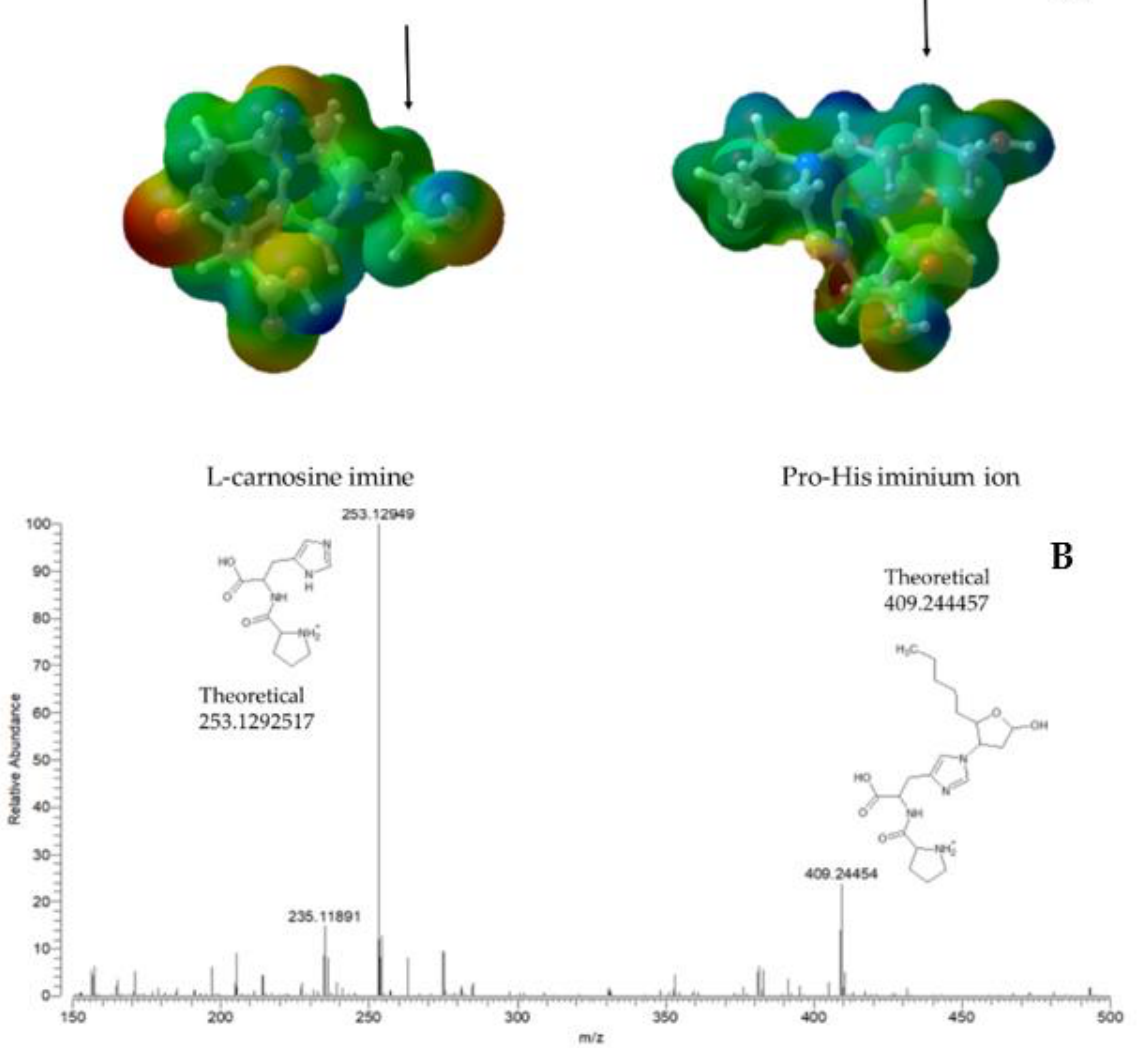
Figure 3. Comparison between the MEP surfaces (blue and red areas encode for electropositive and electronegative regions) for the imine intermediate of L -carnosine with HNE (here and in the following DFT simulations the pentyl chain was removed to speed up the calculations) and the corresponding iminium ion of Pro-His (( A ) the black arrow points out the reactive β carbon atom) and mass spectrum (positive-ion mode) of the reaction mixture (Pro-His + HNE) after 3 h incubation ( B ).